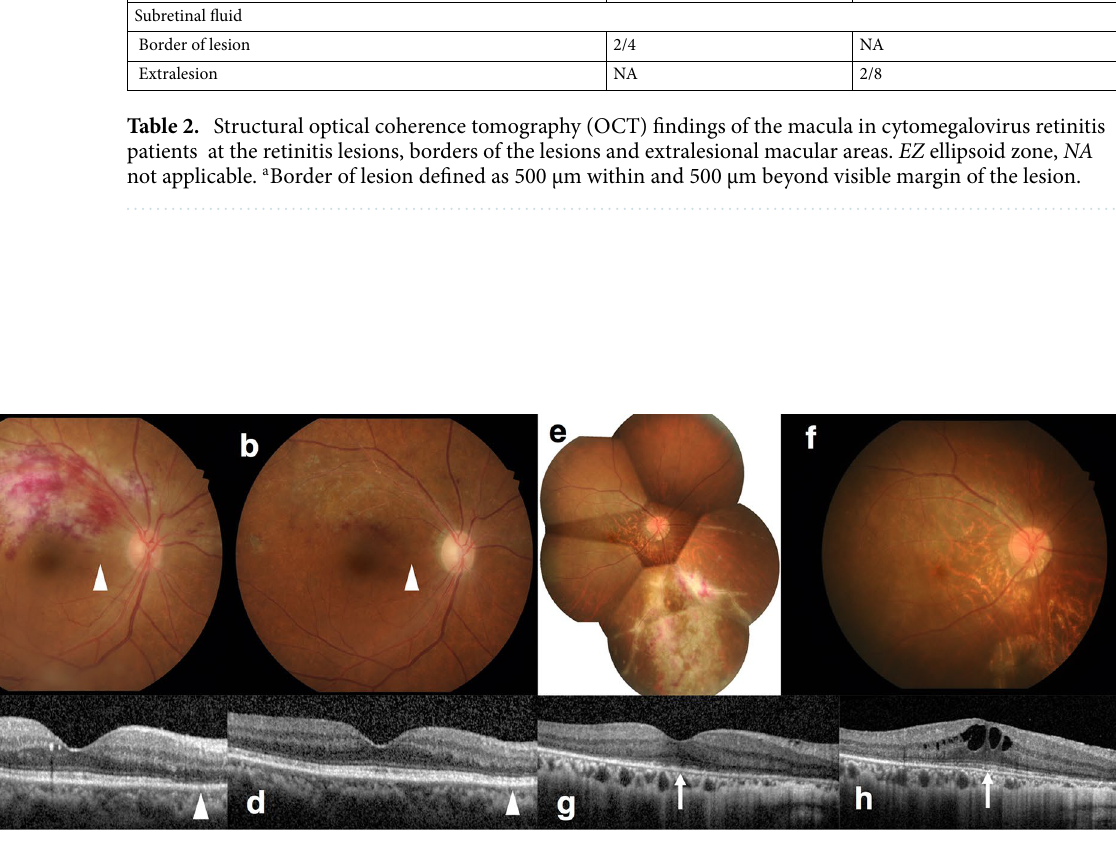
Figure 1. Recovery of ellipsoid zone (EZ) disruption in cytomegalovirus retinitis (CMVR) Patient No.2 ( a – d ). Fundus photograph ( a ) shows retinal infiltrates and intraretinal hemorrhages at the superotemporal quadrant involving the macula. The corresponding optical coherence tomography (OCT) scan ( c ) at the level of fovea demonstrates loss of EZ at the border of the active lesion (arrowheads in a and c ). After treatment, the lesion subsided ( b ) with recovery of EZ on the registered OCT scan ( d ) at the exact location (arrowheads in b and d ). Patient No. 6 ( e – h ). Fundus photograph ( e ) and macular OCT ( g ) of the right eye with an active CMVR lesion show extralesional EZ loss at the macula (arrow in g ). Partial recovery of EZ at the center of fovea was observed after therapy (arrow in h ) with some cystoid macular edema and mild pigmentary changes of the macula on the fundus photograph ( f